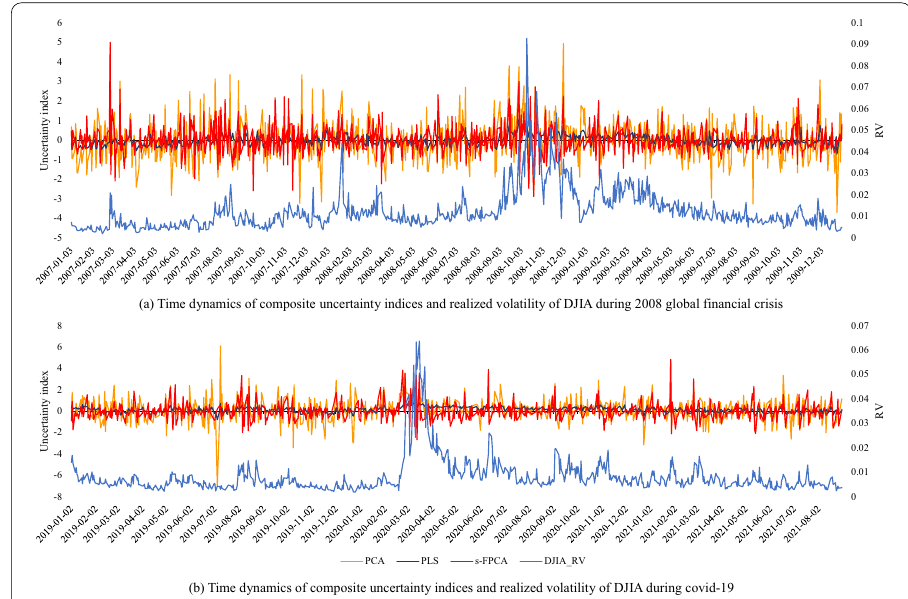
Fig. 6 Comparison of uncertainty indices before and after